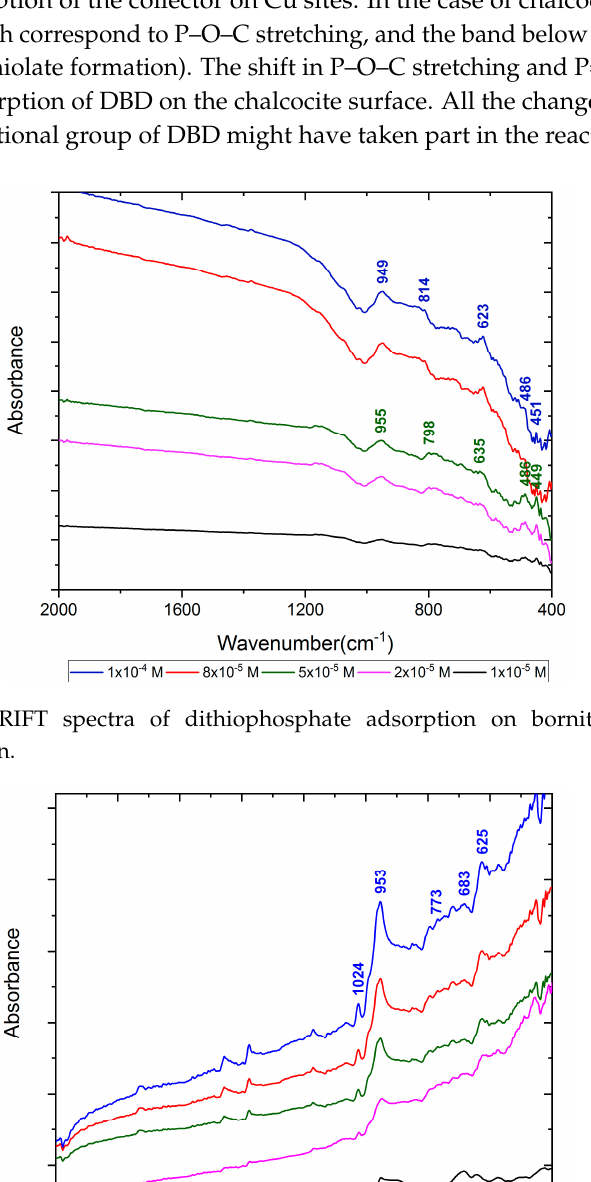
Figure 19. The DRIFT spectra of dithiophosphate adsorption on chalcocite with increasing collector